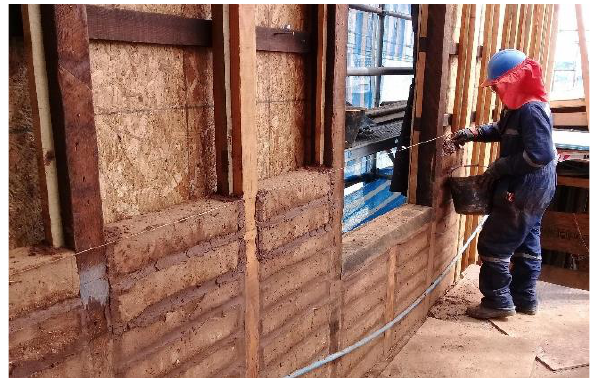
Figure 10. Installation of adobillo bricks.